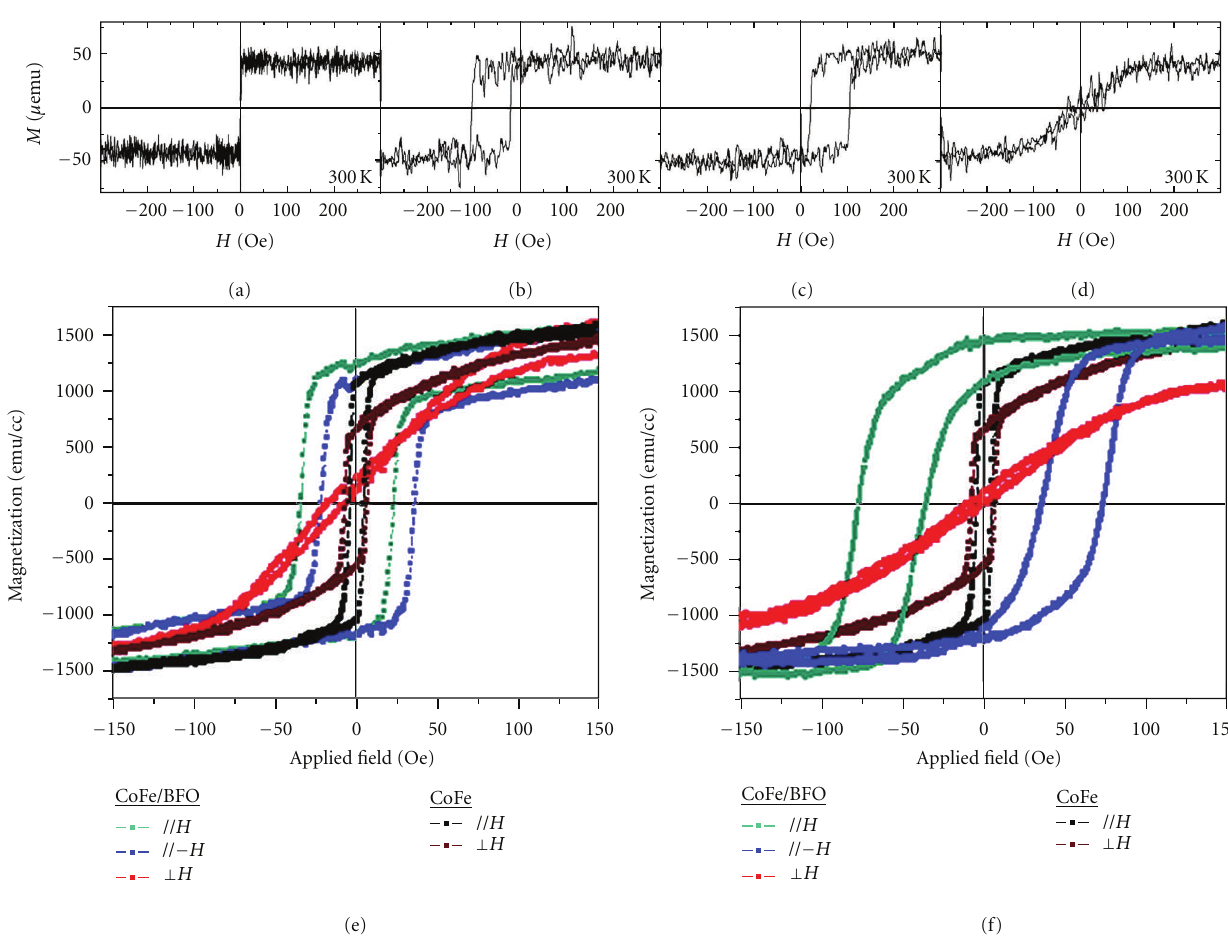
Figure 3: Hysteresis loop along (a) [100] direction of CoFeB (5nm) (cid:5) Si layer, (b) [100] direction, (c) [100] direction, and (d) [010] direction of CoFeB (5nm)/BFO (35nm) (cid:5) STO bilayer. (e) and (f) room temperature magnetic properties of CoFe/BFO heterostructure showing improvement of coercivity and exchange bias, respectively. (a)–(d) were reproduced from B´ea et al. [43], and (e) and (f) were reproduced with permission from Martin et al.